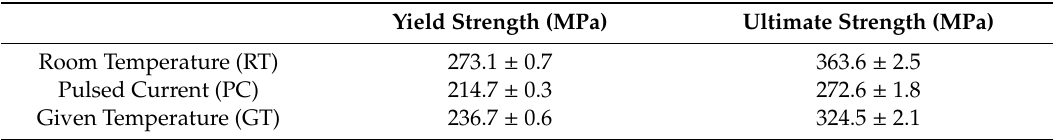
Figure 2. ( a ) Engineering stress–strain curves of tensile tests at room temperature (RT, black line), pulsed current (PC, red line), and given temperature (GT, blue line); ( b ) The temperature of samples measured during tensile tests at room temperature (RT, black line) and pulsed current (PC, red line). Table 2. Tensile properties at RT, PC, and GT conditions of as-extruded AZ80 magnesium alloy in this work.